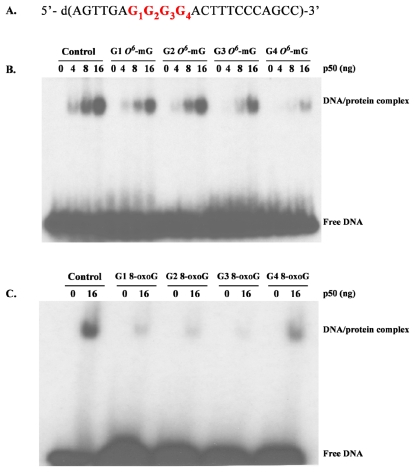
Autoradiograms showing the gel shift induced by binding of the p50 subunit of NF-kB to its DNA recognition sequence containing a DNA lesion. (A) Recognition sequence for the p50 subunit of NF-kB. Four oligonucleotides, each containing a guanine (G) or either an O6-mG (B) or 8-oxoG (C) located in the consensus sequence of the p50 subunit, were incubated with different concentrations of purified p50, electrophoresed and the autoradiograms examined for bands by chemiluminescence. The concentration dependence of the DNA-p50 complex was demonstrated by the addition of 0, 4, 8, or 16 ng of purified p50 in the reaction mixture. This suggests that binding of the transcription factor (NF-kB) to its cognate DNA recognition sequence is altered both by the nature and the specific location of the DNA lesion (images derived from unpublished data).